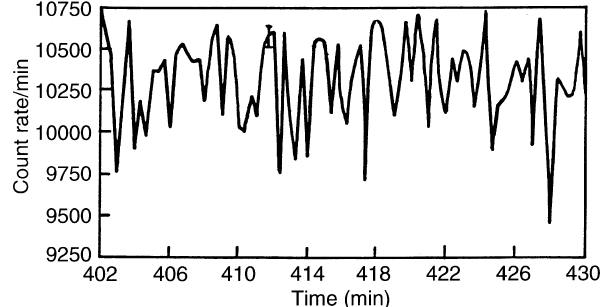
Fig. 2. The time dependence of the omnidirectional charged particle flux registered on balloon flight over Bauru on 8–9